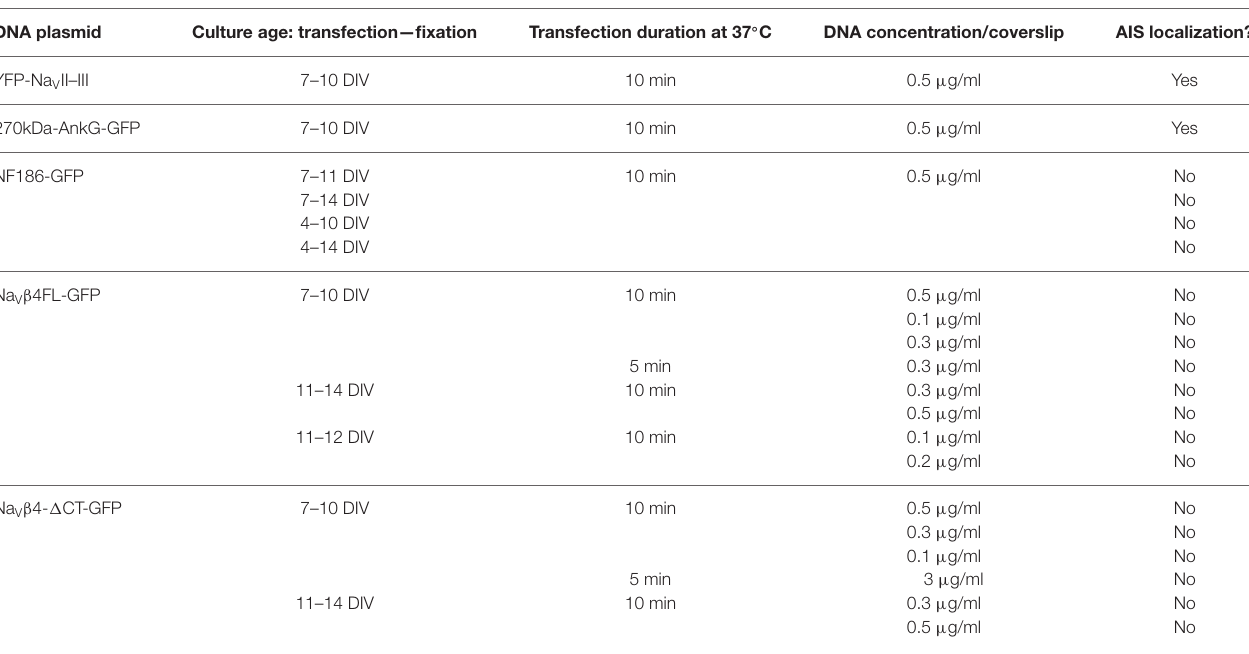
TABLE 2 | Transfection protocols for genetically-encoded AIS markers. DNA